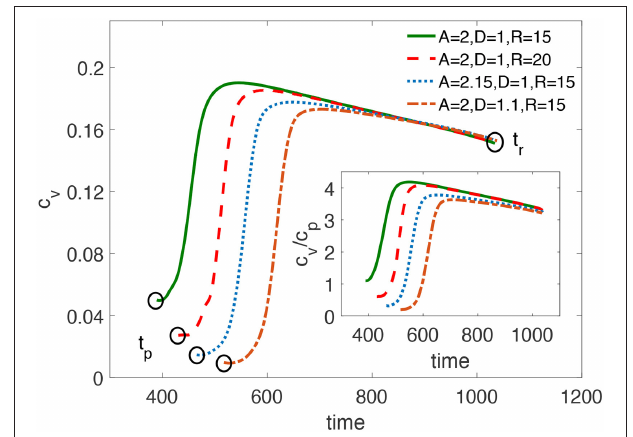
FIGURE 8 | The propagation speed c v of the penetrated excitation along the vertical flat boundary of a FPR over time. t p is the time when the penetration at the FPR corner starts. t r is the time when the PCP initially emerges. Larger D , A , or R lead to a delayed t p , but nearly the same t r . The subfigure shows the change of the ratio between c v and c p over time, where c p is the plane wave velocity for the medium’s parameters established inside the